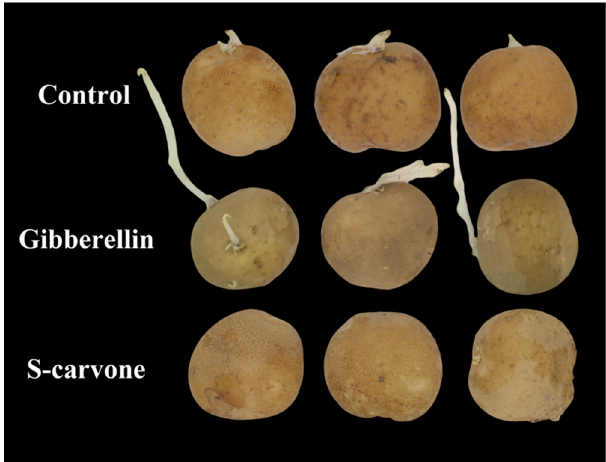
Figure 2. Effects of gibberellin and ( S )-carvone on sprouting in potato tubers at 90 days of 4 °C low temperature storage.